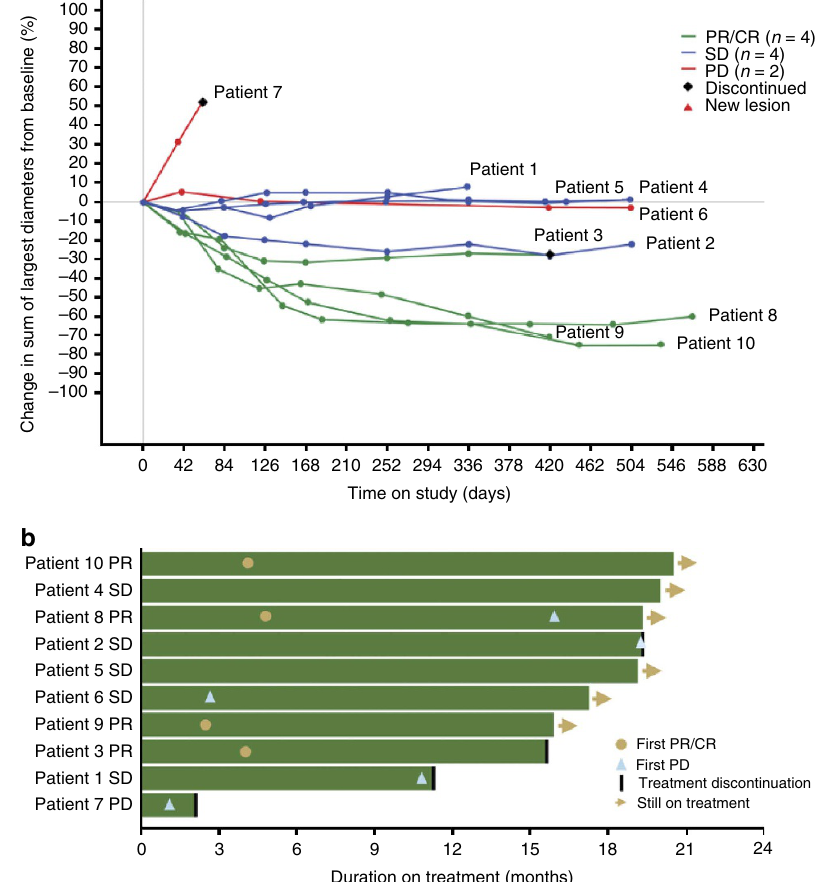
Figure 1 | Antitumour activity of atezolizumab and bevacizumab combination. ( a ) Tumour burden over time in RCC patients. Plot of patients with RCC measuring the maximum reduction from baseline in the sum of the longest diameter for target lesions. CR, complete response; PD, progressive disease; PR, partial response; SD, stable disease. ( b ) Duration of study treatment for patients with RCC.